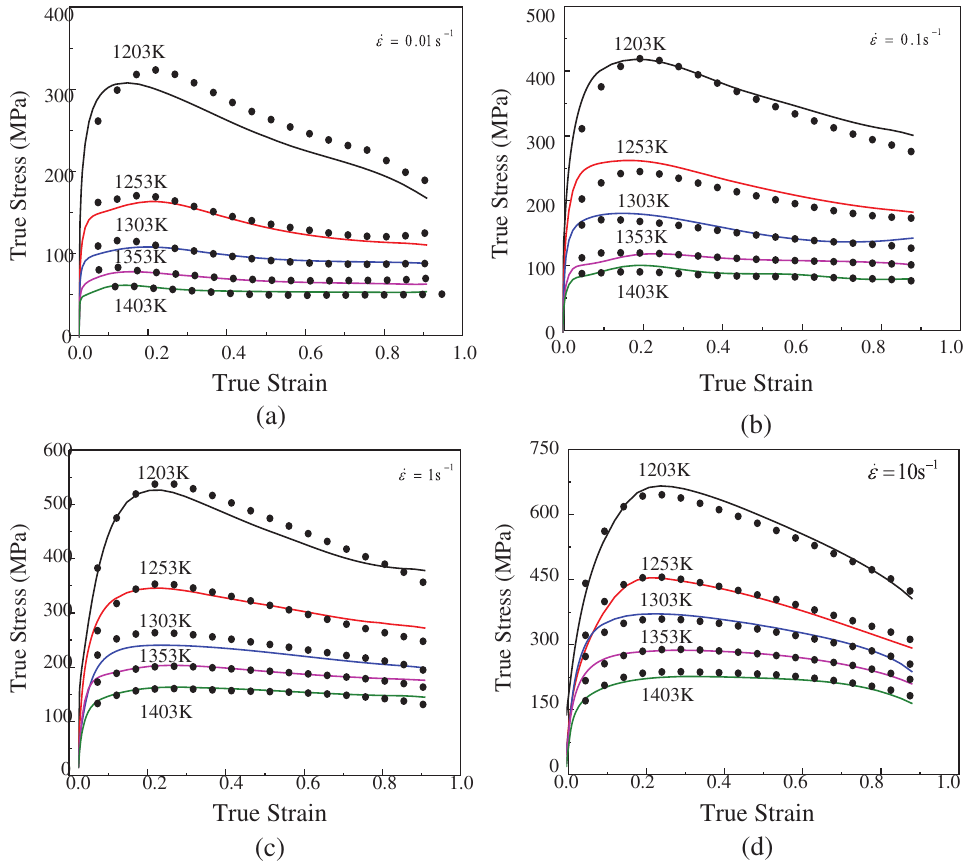
Figure 8: The comparisons between the experimental (curves) and predicted (black circles) true stress by the Arrhenius-type constitutive equation under the strain rates of (a) 0.01s − 1 , (b) 0.1s − 1 , (c) 1s − 1 and (d) 10s − 1